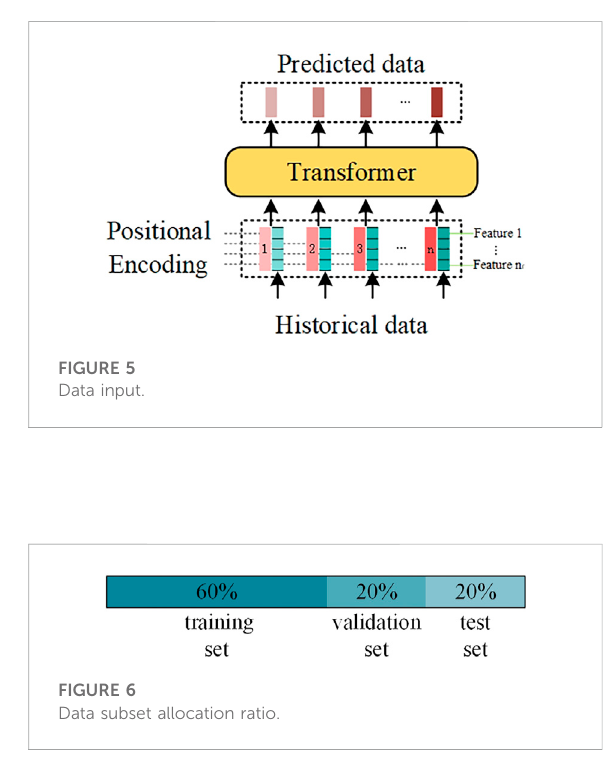
FIGURE 5 Data input.